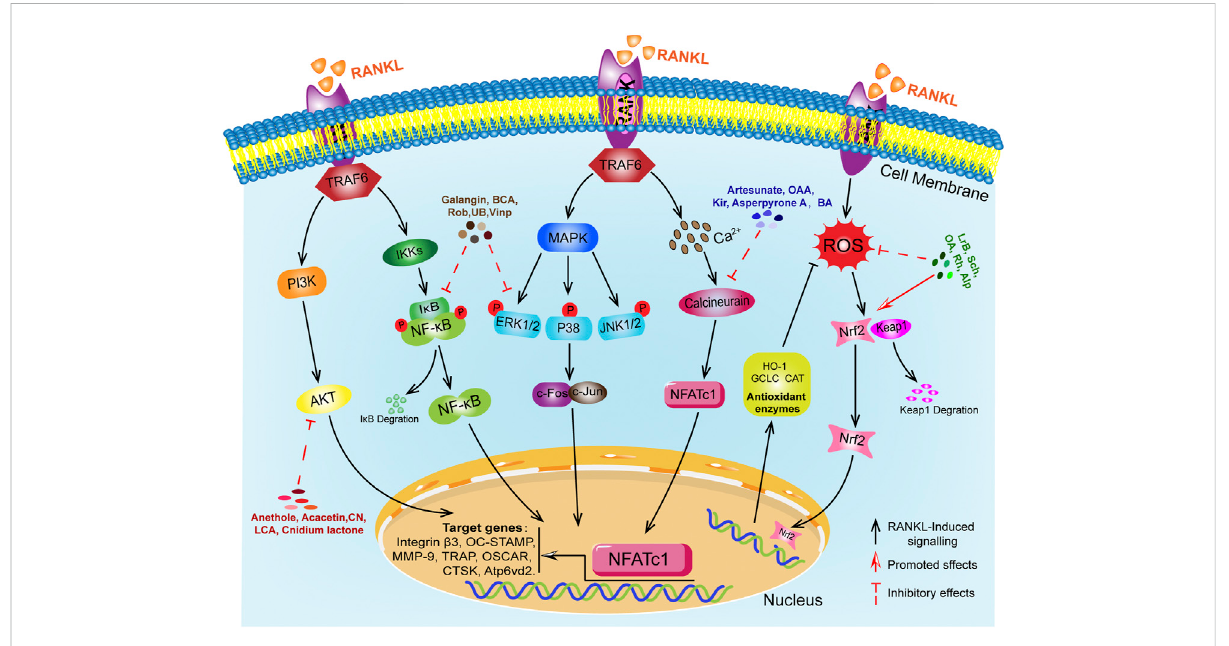
FIGURE 2 RANKL-mediated osteoclast differentiation signaling pathway and 20 natural